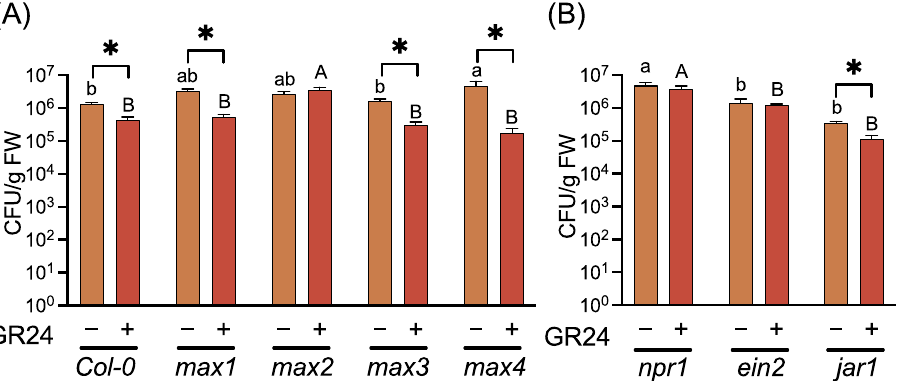
Figure 4. Effects of GR24 treatment on growth of Pseudomonas syringae pv. tomato DC3000 in Arabidopsis leaf tissues. Three-week-old plants of WT and SL-related mutants ( A ) and SA-, ET-, and JA-related mutants ( B ) were treated with 0.02% acetone (control) (–) or 10 µ M GR24 (+) by drenching the